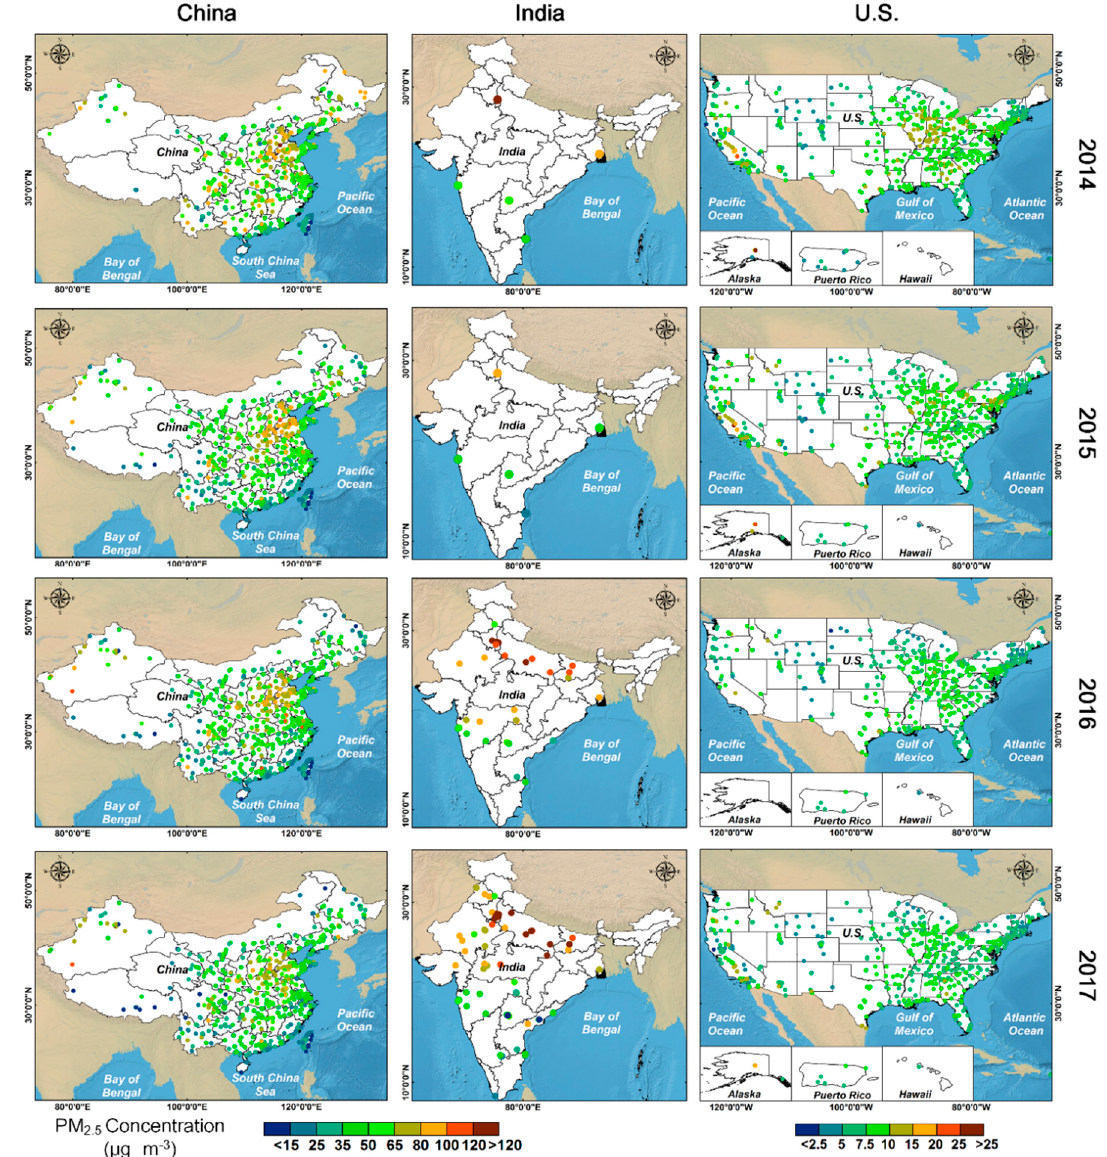
Figure 4. Spatial distribution of annual PM 2.5 concentrations for China, India, and the U.S. from 2014 to 2017.